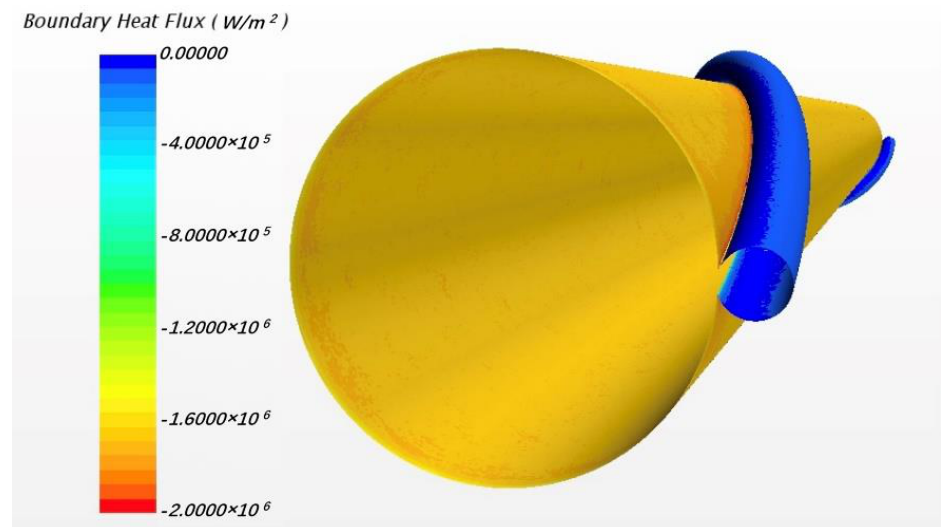
Figure 23. Heat fluxes at eight times thermal conductivity of sodium .